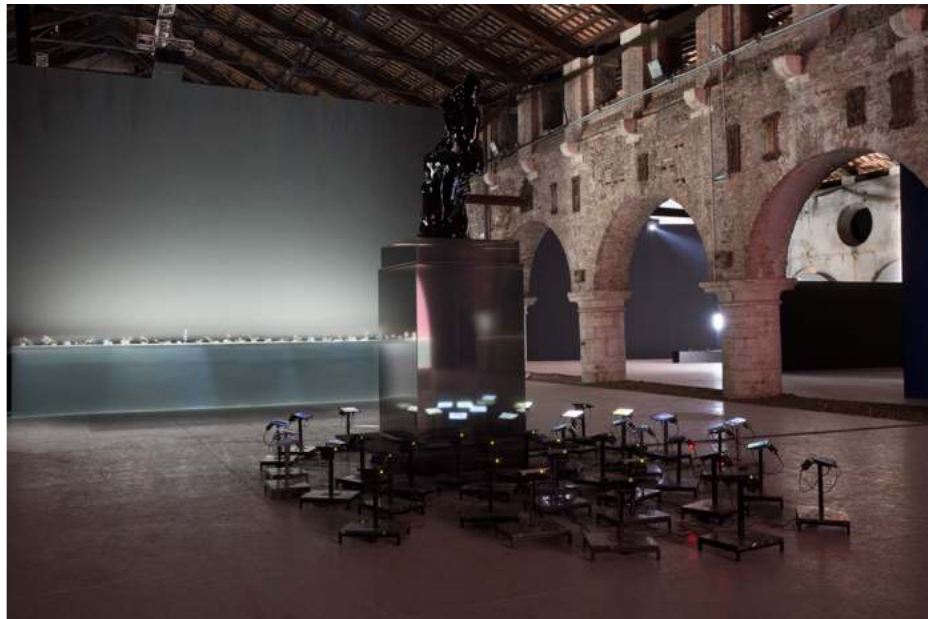
Figure 4: HyperPavilion , courtesy of Philippe